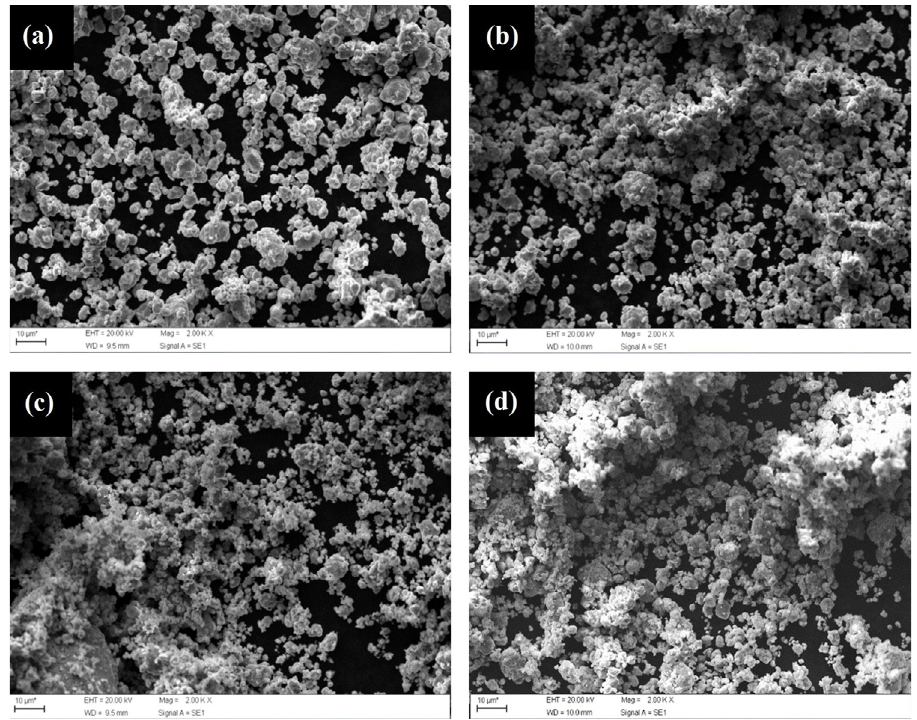
Figure 4. SEM of the AISI 52100 steel milled through 30 hours with (a) 0% of alumina (b) 1% of alumina (c) 3% of alumina (d) 5% of alumina